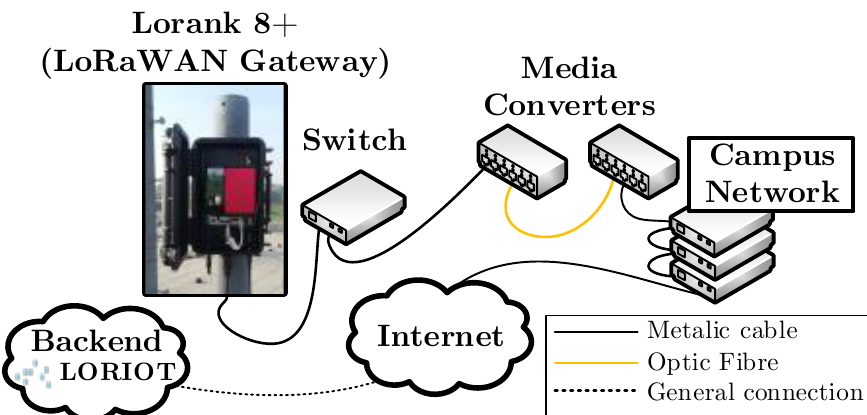
Figure 5. Topology of our LoRaWAN experimental single-gateway network.